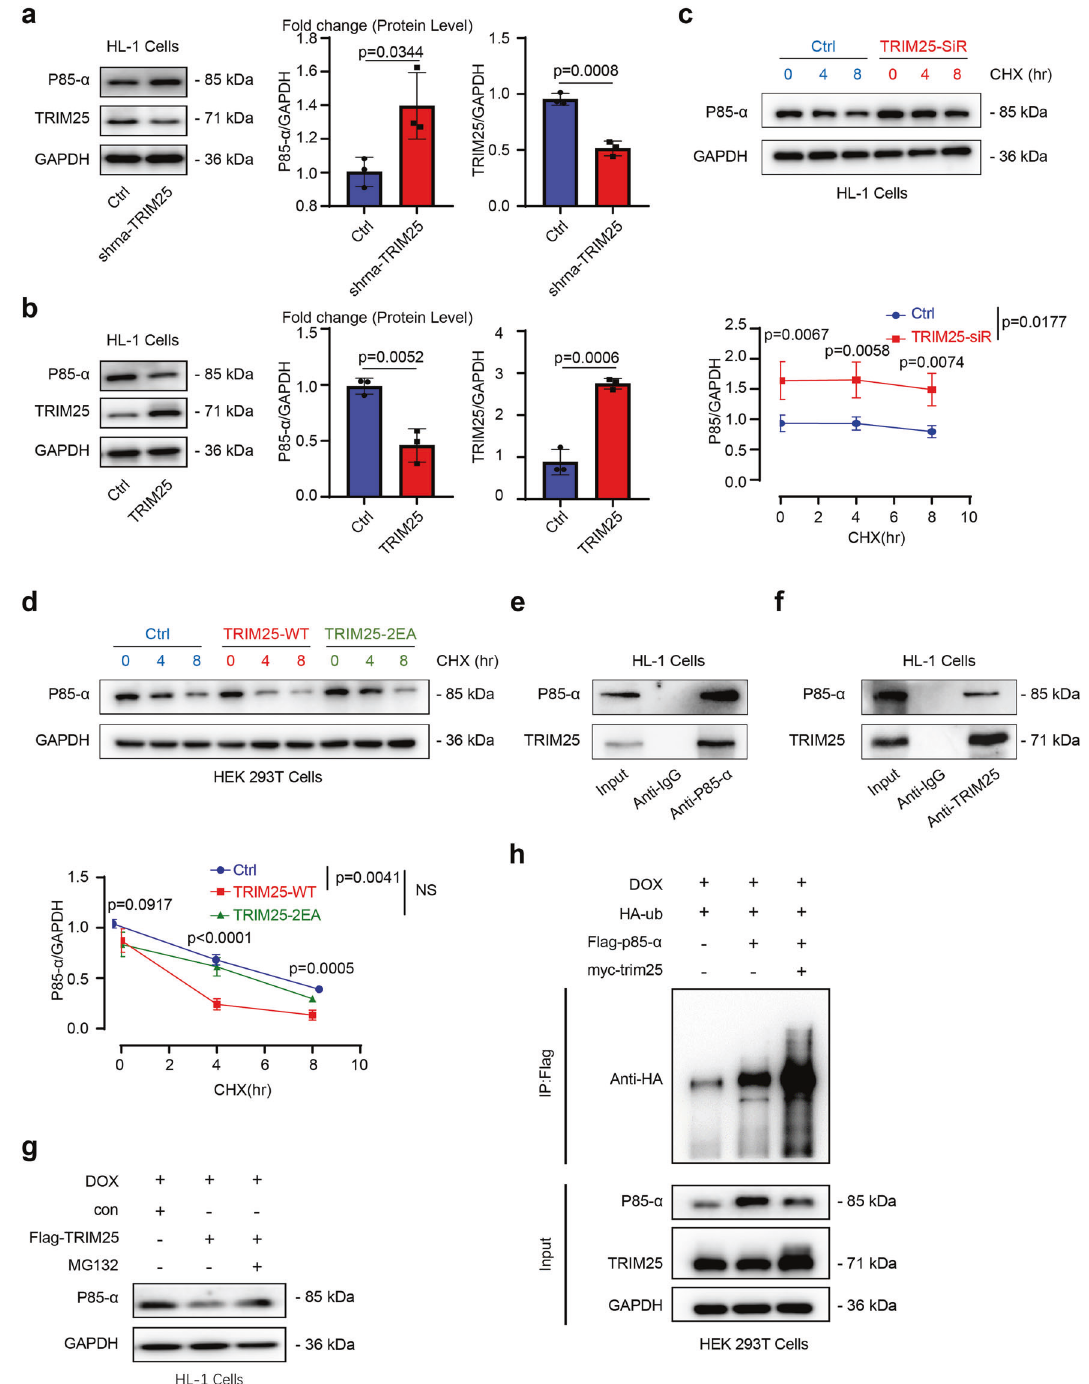
Fig. 2 TRIM25 decreases p85 α stability via ubiquitination. a Western blot analysis of p85 α and TRIM25 levels in HL-1 cells transfected with shRNA-TRIM25 (1 μ g/ml) or control shRNA. b Western blot analysis of p85 α and TRIM25 in HL-1 cells transfected with TRIM25 overexpression plasmids (TRIM25-WT) (1 μ g/ml) or control plasmid. c Representative immunoblot and relative quanti fi cation of p85 α in HL-1 transfected with shRNA-TRIM25 or shRNA-Ctrl (1 μ g/ml), then treated with CHX (100 μ g/ml) for up to 8 h. d Representative immunoblot and relative quanti fi cation of p85 α in HL-1 transfected with control plasmid, TRIM25-WT or TRIM25-2EA mutation plasmids (TRIM25-2EA) (1 μ g/ml), then treated with CHX (100 μ g/ml) for up to 8 h. e, f Co-immunoprecipitation (CO-IP) assay analyzed the interaction of endogenous TRIM25 and p85 α in HL-1 cells. g Western blotting assessed the level of p85 α in HL-1 cells treated with or without MG132 (20 μ M) for 12 h. h HL-1 cells transfected with the plasmids as indicated and treated with DOX (1 μ M) for 12 h. Immunoblot analysis of the cell lysates and p85 α -IP with the indicated antibodies. Data represent the means ± SEM. ( n = 3). P values were determined by unpaired 2-tailed Student t test ( a , b ) and two- way ANOVA between multiple groups ( c , d ). WT, wild-type; ctrl, control; TRIM25-2EA, TRIM25 mutant with Glu9 and Glu10 changed into Ala.